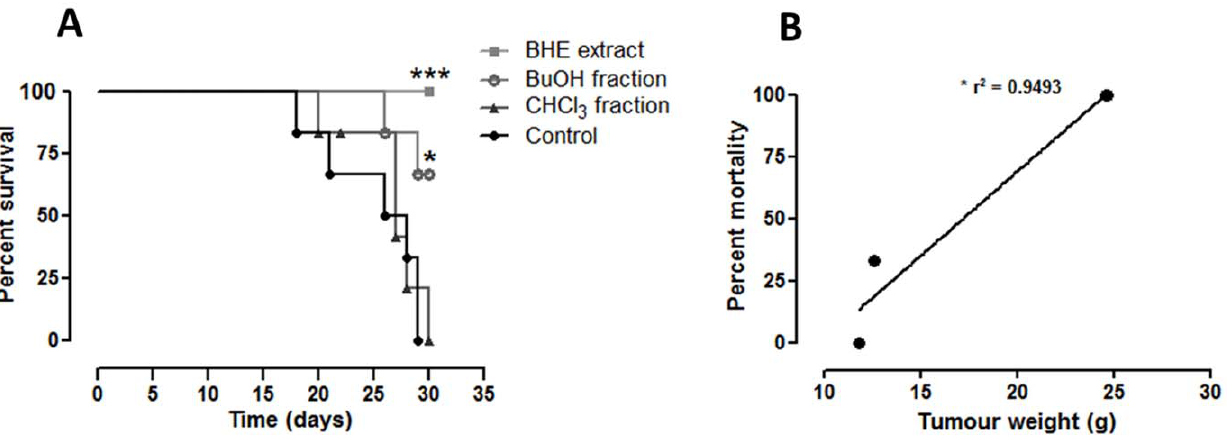
Figure 8. Survival analysis of W256 tumour-bearing rats treated with U.tomentosa BHE extract or its two fractions (BuOH and CHCl 3 ) during 30 days (A). Data is expressed as percentage of survival as per the logrank (Mantel-Cox) test. (B) Correlation between tumour weight (g) and survival rate (%) analysed by linear regression. Symbols: * p , 0.05 and *** p , 0.001 as compared to the control